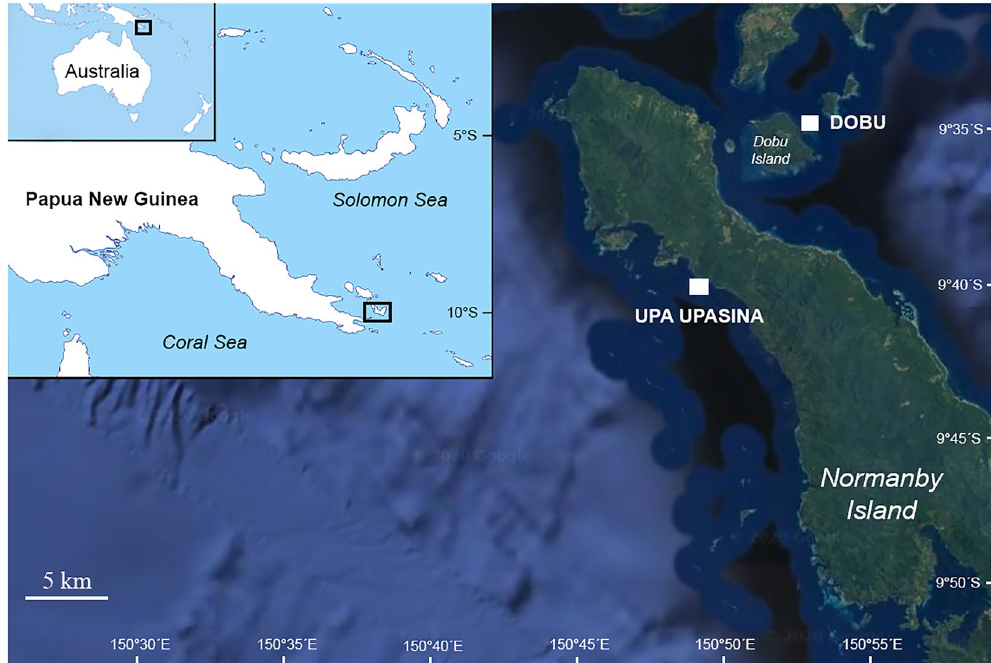
Figure 1. Maps of Papua New Guinea and the two study locations (Dobu and Upa Upasina) on Normanby and Dobu Islands, Milne Bay Province. This Figure was created using Adobe Photoshop CC 2018 (https:// www. adobe. com/ produ cts/ photo shop. html) with imagery from Google Earth (V 9.140.0.4. Eye alt 45 km. SIO, NOAA, U.S. Navy, NGA, GEBCO. TerraMetrix 2020, Digital Globe 2020. https:// earth. google.